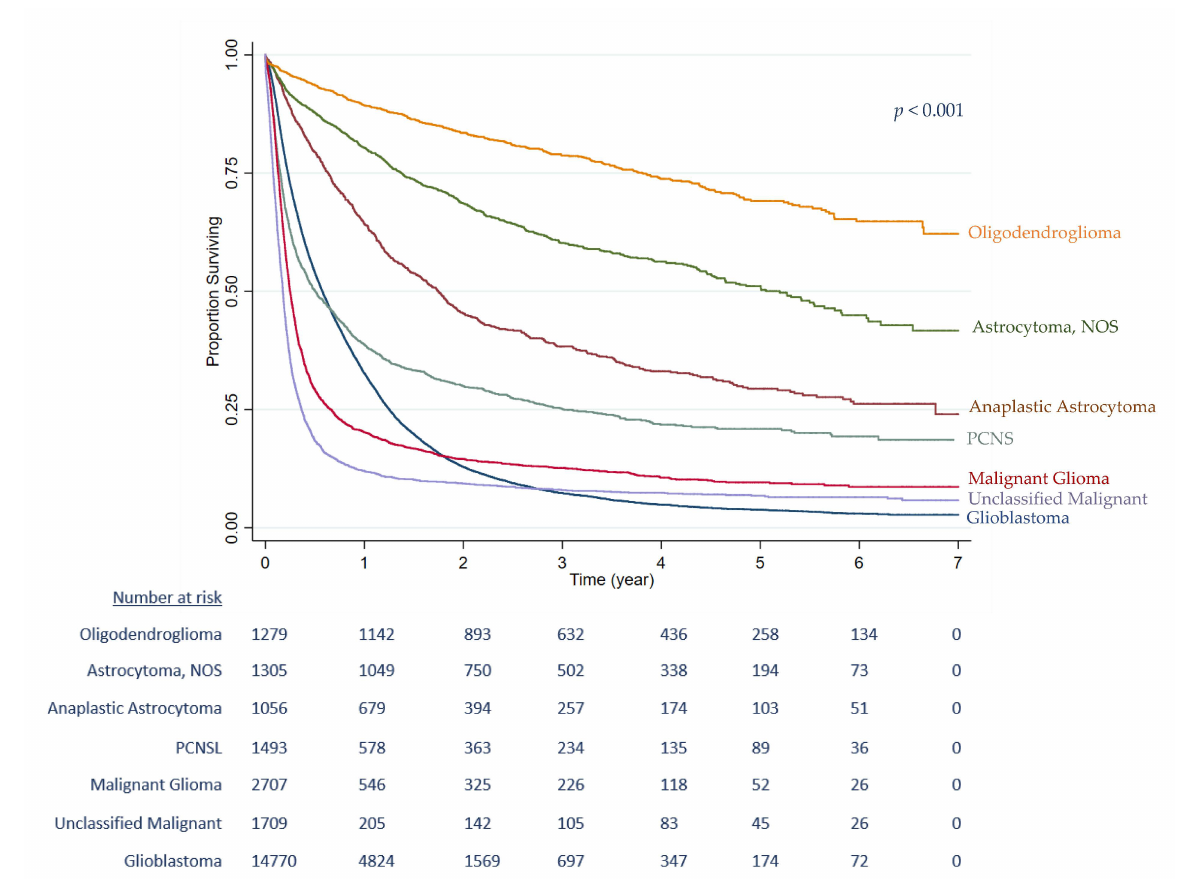
Figure 2. Kaplan-Meier survival curves by brain tumour morphology, England 2012–2017. The ethnic difference in survival was further explored by investigating whether there was any interaction between ethnicity and glioblastoma diagnosis, route or pathway to diagnosis, and optimal treatment received (Table 4). The Any Other White Group were more likely to be diagnosed through a hospital stay that included an emergency admission (OR 1.16, 95% CI 1.02–1.33). The Other Ethnic Group were nearly a third more likely to receive the diagnosis of glioblastoma (OR 1.28, 95% CI 1.04–1.56) than the White British Group. However, individuals with Unknown/Not Stated Ethnicity had the most favourable prognosis and were less likely to be diagnosed with a glioblastoma (OR 0.70, 95% CI 0.58–0.84), less likely to be diagnosed through a hospital stay that included an emergency admission (OR 0.61, 95% CI 0.53–0.69), and more likely to receive the optimal treatment option for their other-than-glioblastoma diagnosis (OR 0.39, 95% CI